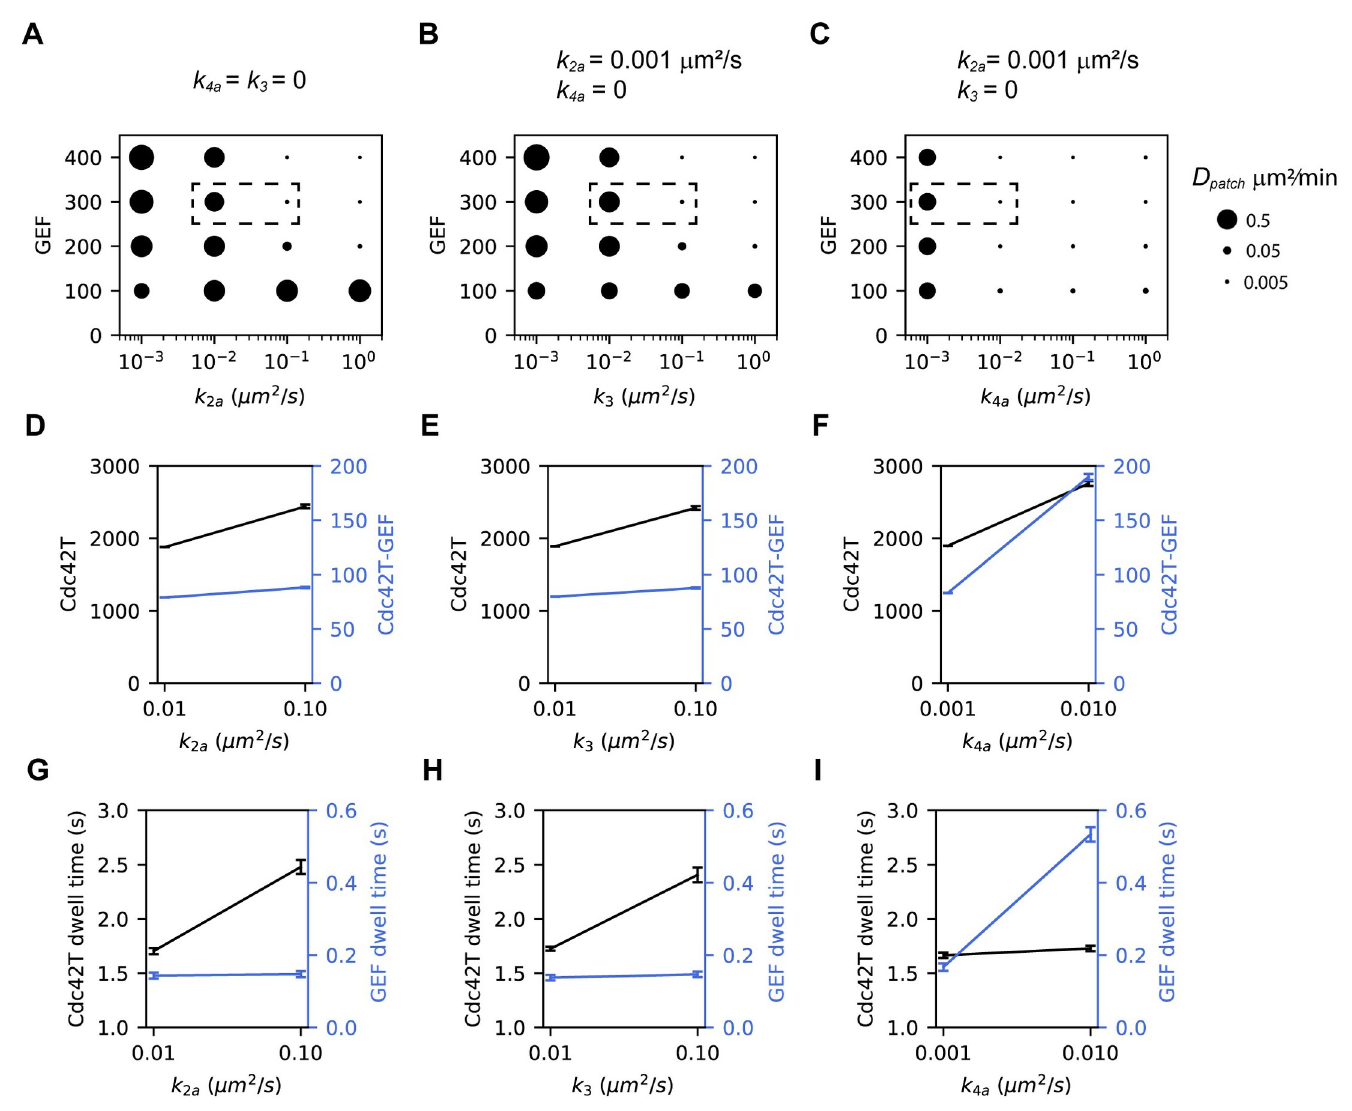
Fig 7. Association reactions at the membrane stabilize clusters by trapping polarity factors at the patch. Patch centroid diffusivity ( D patch ) as a function of the total number of GEF molecules and k (A) , k (B) , k (C) . The size of the dots reflects the magnitude of D as indicated in the legend at the right. For each case, the value of 2a 3 4a patch the other two rate constants is shown above the panel. (D-F) The amounts of Cdc42 and GEF at the patch are quantified as the total Cdc42T (black) and Cdc42T-GEF (blue) respectively for the corresponding points enclosed by dashed boxes in (A-C) . (G-I) Dwell times at the patch of Cdc42T (black) and GEF (blue) for the corresponding points enclosed by dashed boxes in (A-C) (see Methods for details). Error bars are the standard deviation from estimations in 10 independent